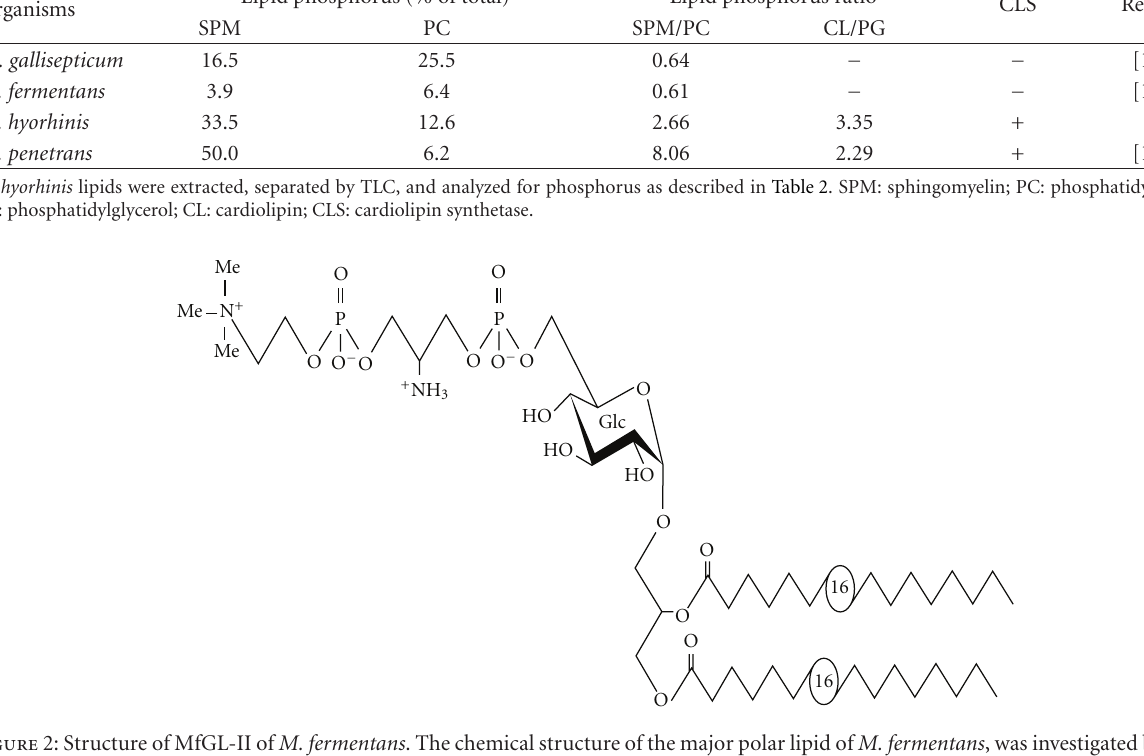
Figure 2: Structure of MfGL-II of M. fermentans . The chemical structure of the major polar lipid of M. fermentans , was investigated by GLC- MS, MALDI-TOF mass spectrometry, as well as one-and two-dimensional homo- and heteronuclear NMR spectroscopy and identified as 6 (cid:2) - O -[3 (cid:2)(cid:2) -phosphocholine-2 (cid:2)(cid:2) -amino-1 (cid:2)(cid:2) -phospho-1 (cid:2)(cid:2) ,3 (cid:2)(cid:2) -propanediol]- α -D-glucopyranosyl-(1 (cid:2) → 3)-1,2-diacyl-glycerol (MfGL-II). Palmitate (16:0) and stearate (18:0), in a 3.6 :1 molar ratio, constitute the major fatty acids present